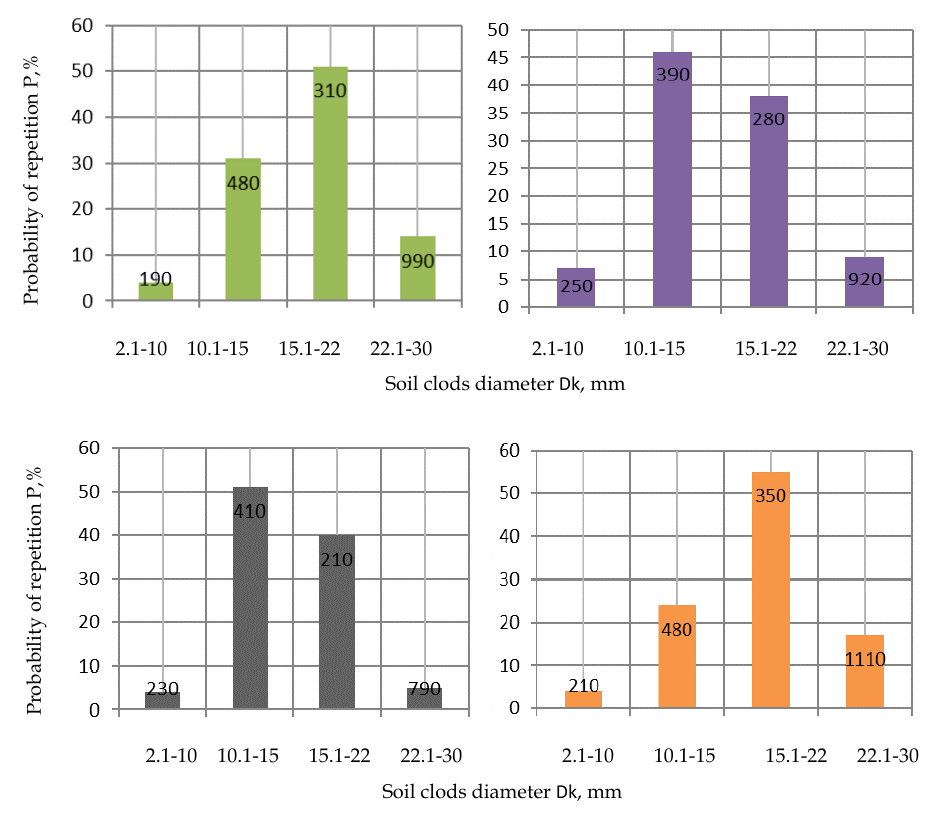
Figure 11. Fractional composition and mass of soil clods.